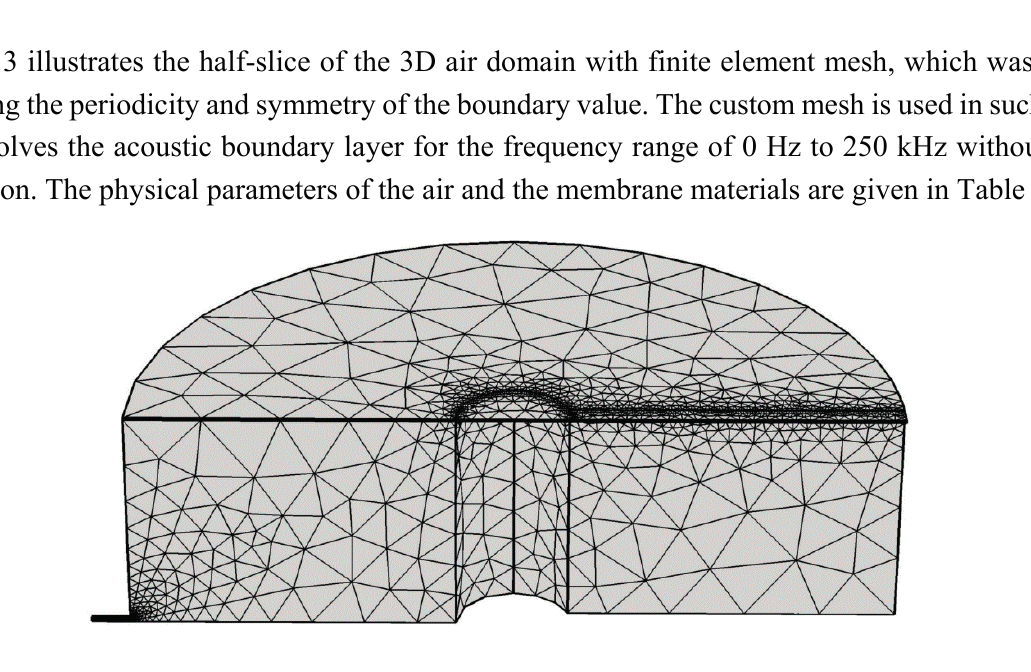
Figure 3. Half-slice of air domain (symmetrical part) of the acoustic sensor with finite element mesh. Table 2. List of parameters of the thermoviscous fluid (air) and material properties of the membrane.